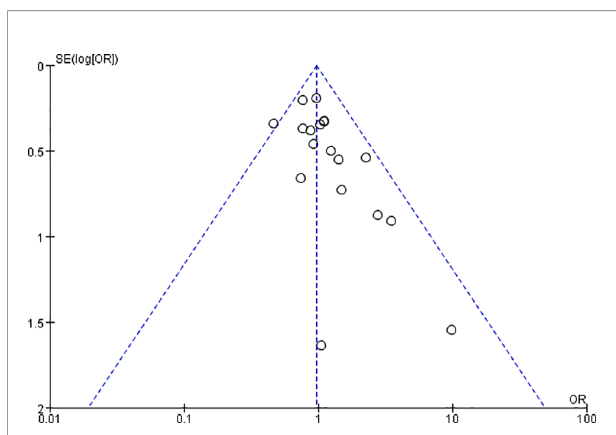
FIGURE 8 | Funnel plot of PCR publication